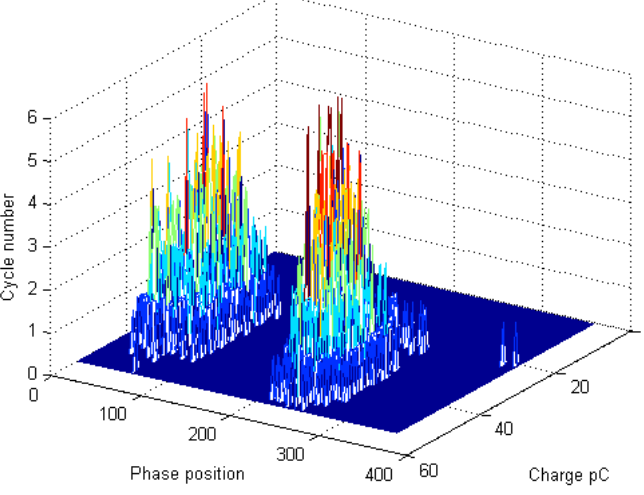
Figure 12. Typical 3D PD pattern.